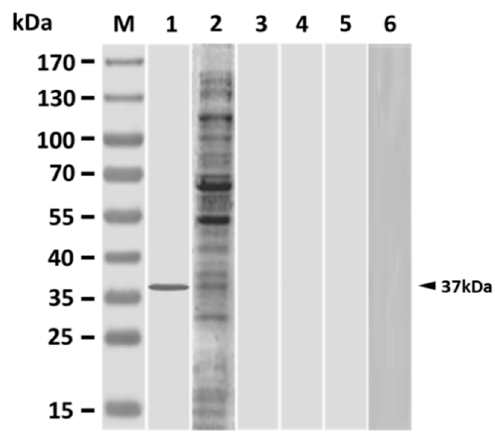
Figure 1. Antigenic specificity of sera from vaccinated grouper. Three weeks after vaccination, V. harveyi lysate was analyzed with sera from grouper peritoneally vaccinated with a single shot of PLG-encapsulated PLE plus rGAPDH microparticles (PLG-PLE/rGAPDH MPs) (lane 1), a single shot of inactivated bacteria (ISA 763 AVG) (lane 2), a single shot of rGAPDH (lane 3), a single shot of PLE (lane 4), a single shot of PLG empty MPs (lane 5), or a single shot of PBS (lane 6). Standard protein markers (lane M) are shown at the left.